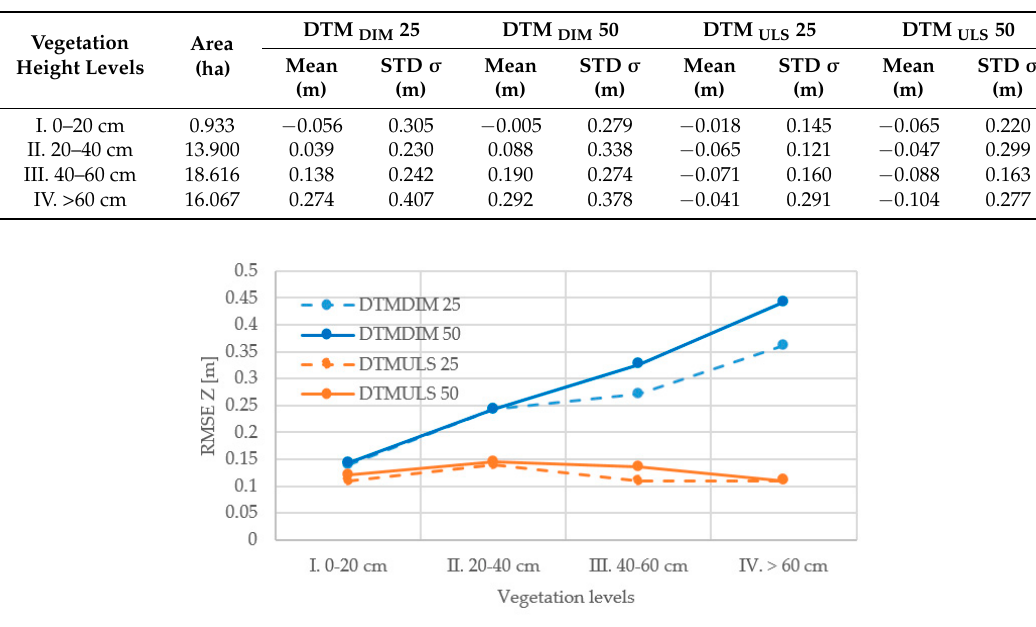
Table 4. Vertical accuracy assessment of DTMs, based on differential DTM referred to airborne laser scanning (ALS) data.